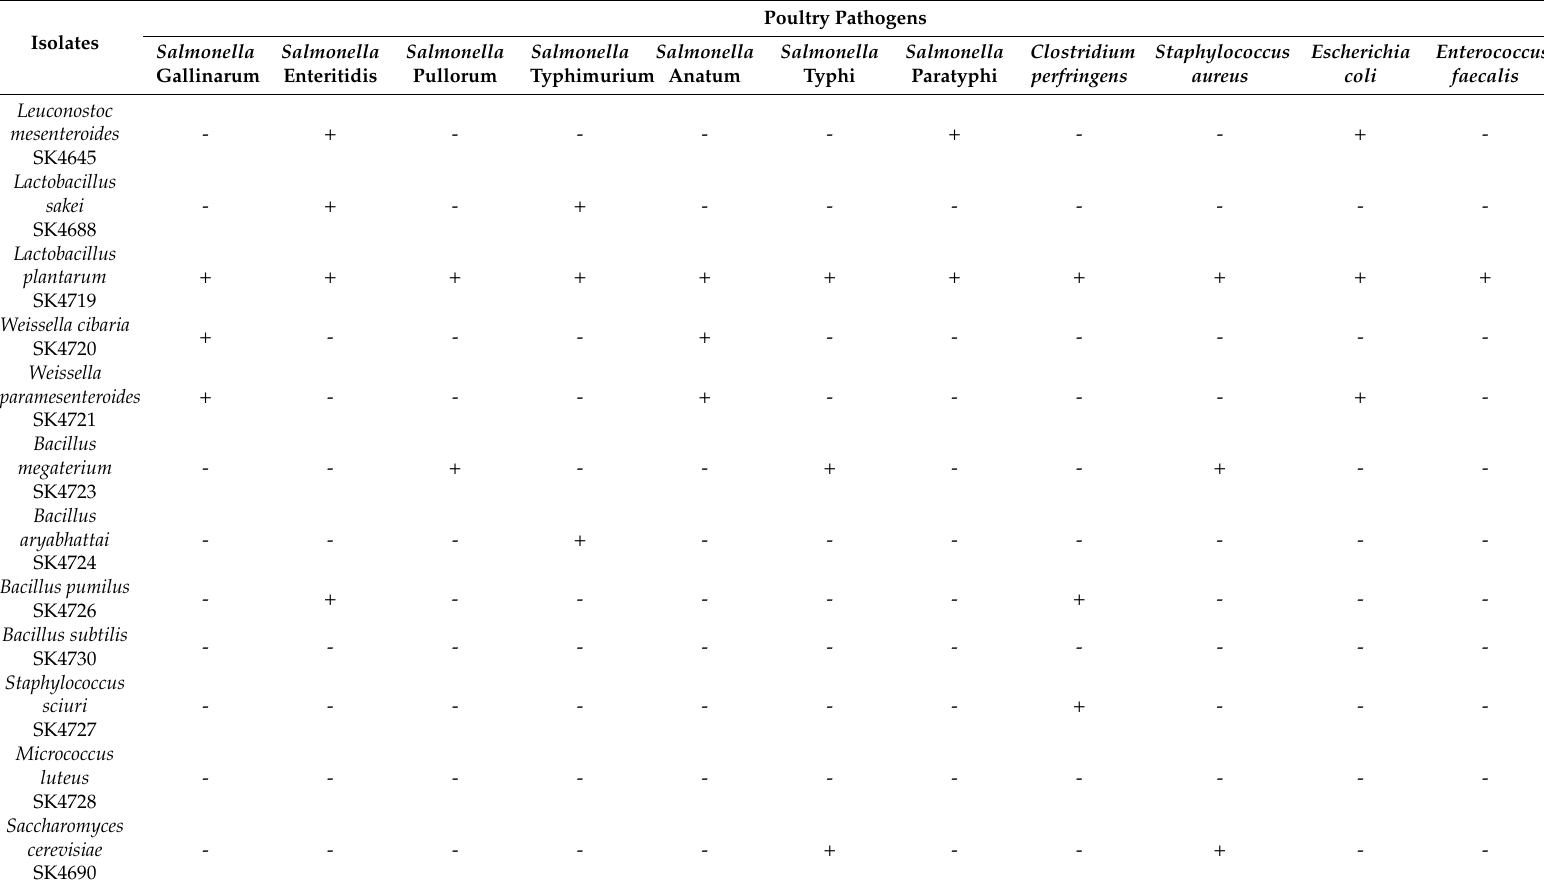
Table 1. Antimicrobial activity of the isolated microorganisms against poultry pathogenic